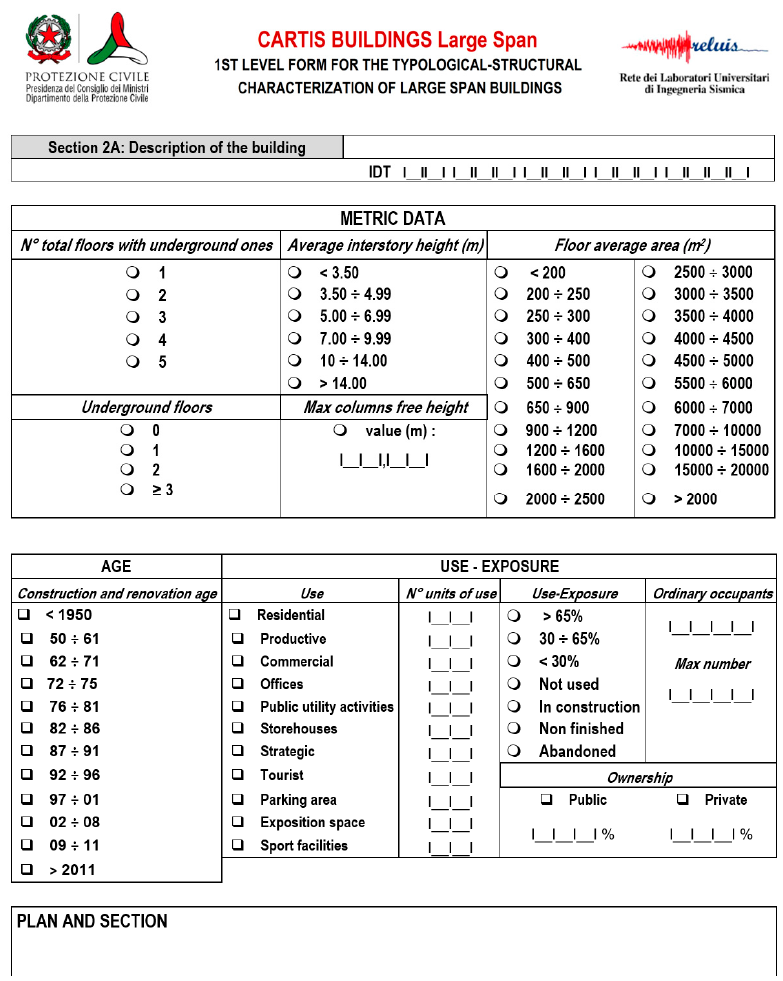
Figure 16. Section 2A CARTIS-Building: Description of the building (English version [19]).